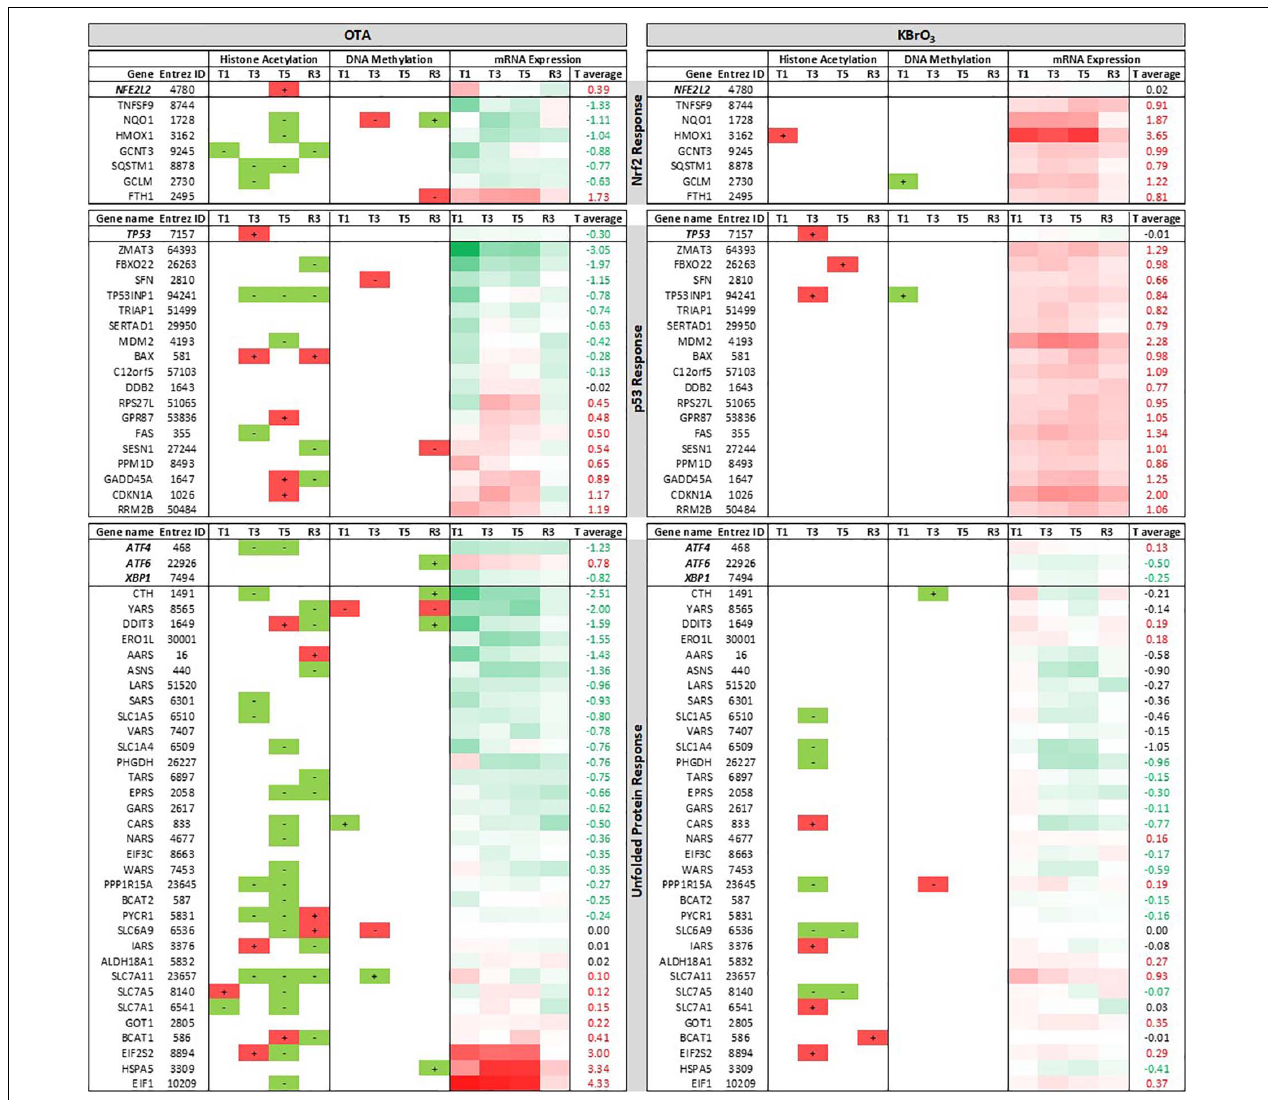
FIGURE 6 | Epigenetic and mRNA changes associated with stress response pathways. Three stress response pathways are described: the Nrf2 response to oxidative and alkylating stress, the p53 response to DNA damage and the unfolded protein response. Gene lists include the governing transcription factors Nrf2 (NFE2L2), p53 (TP53), ATF4, ATF6 and XBP1, followed by some of their target genes. For HA and DM, “+” means hyper- and “–“ means hypo-modifications compared to time-matched control (in all 3 replicates). Red symbolizes modifications that classically promote gene expression for HA and DM / mRNA up-regulation. Green symbolizes modifications that classically reduce gene expression for HA and DM / mRNA down-regulation. Heatmap for mRNA expression ranges from 4 to -2 and is centered to 0 (white). “T average” is the average log2 fold change compared to time-matched control. For each pathway, genes are sorted in descending order of T average in the OTA